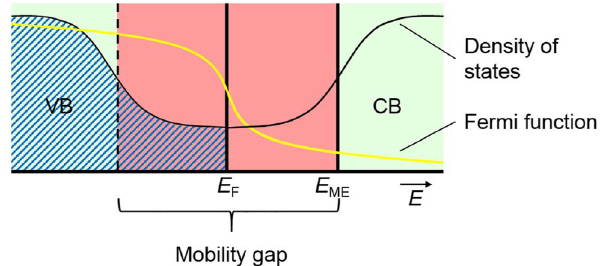
Figure 2. Schematic density of states in amorphous solids. Occupation for energies up to the Fermi energy E F for T = 0 K is shown in blue hatched. Occupations for higher temperatures have to be calculated using the Fermi function (yellow). Within the mobility gap (red area) states are localised. Only electrons above the mobility edge (ME) (right green area) contribute to the electronic conductivity while electrons in the localised states are immobile and therefore have no contribution to the conductivity 27,28